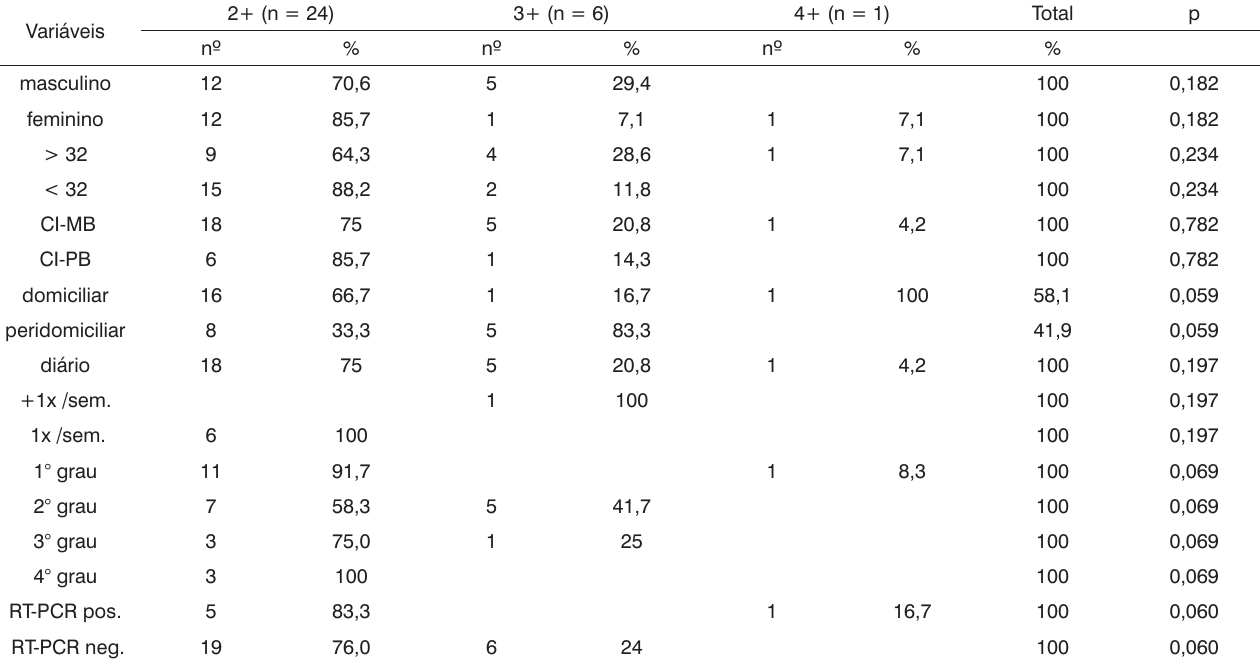
Figura 5. RINITE HANSÊNICA - Endoscopia nasal do controle positivo: mucosa nasal típica da rinite hansênica, onde se evidenciam infiltração difusa da mucosa, resseca- mento, áreas de ulceração superficial, crostas hemáticas (CH), ectasias e áreas de